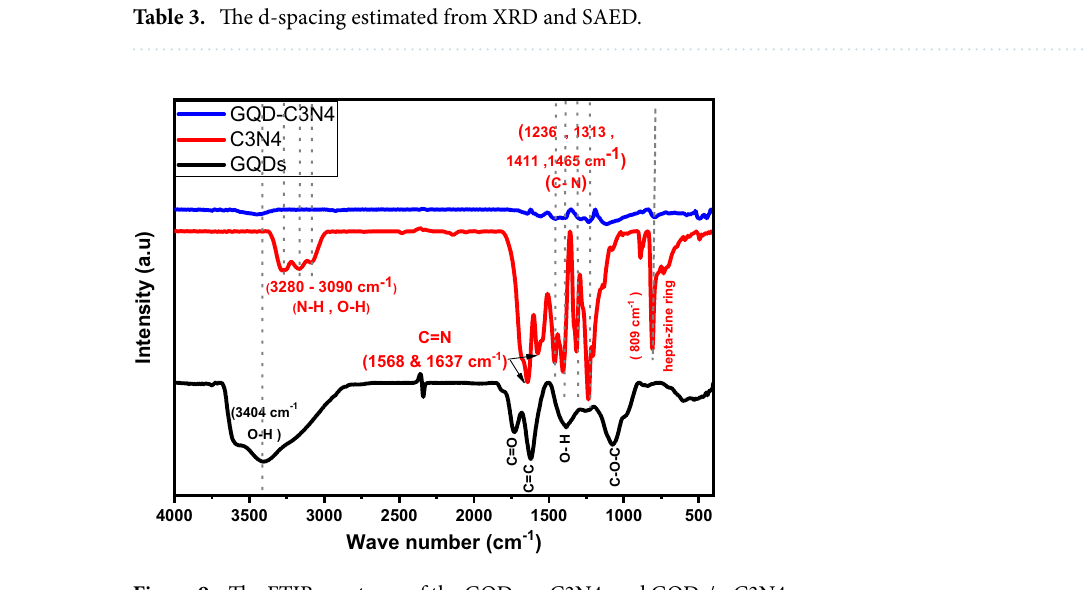
Figure 9. The FTIR spectrum of the GQDs, g-C3N4, and GQDs/g-C3N4.